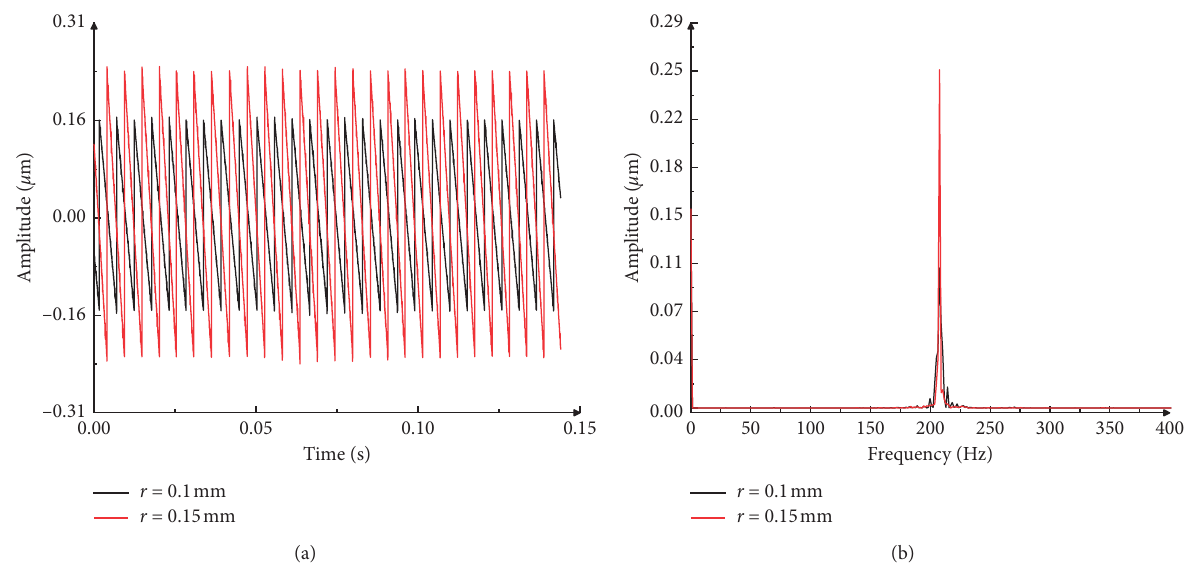
Figure 17: Time-domain and frequency-domain waveforms with the rotating speed of 12000r/min. (a) Time domain. (b) Frequency